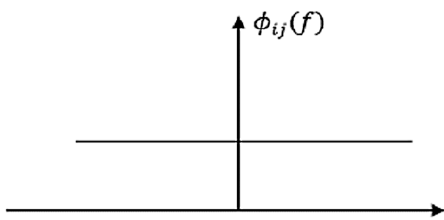
Figure 8. The output of the digital low-pass filter.